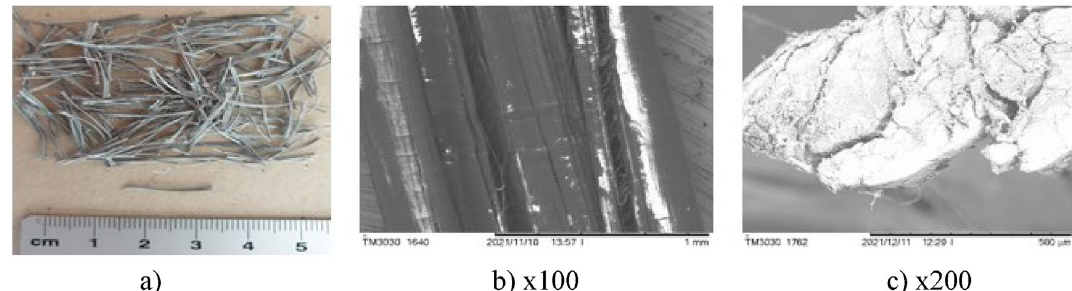
Figure 11. SEM of polymer fibre [Fot.M.Kurpińska].